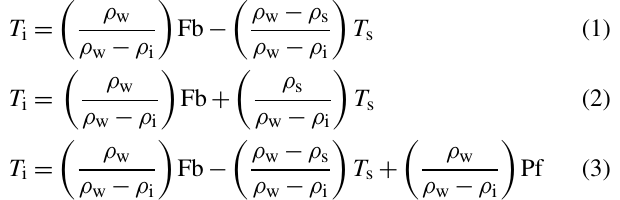
and sea ice density measurements made in McMurdo Sound were